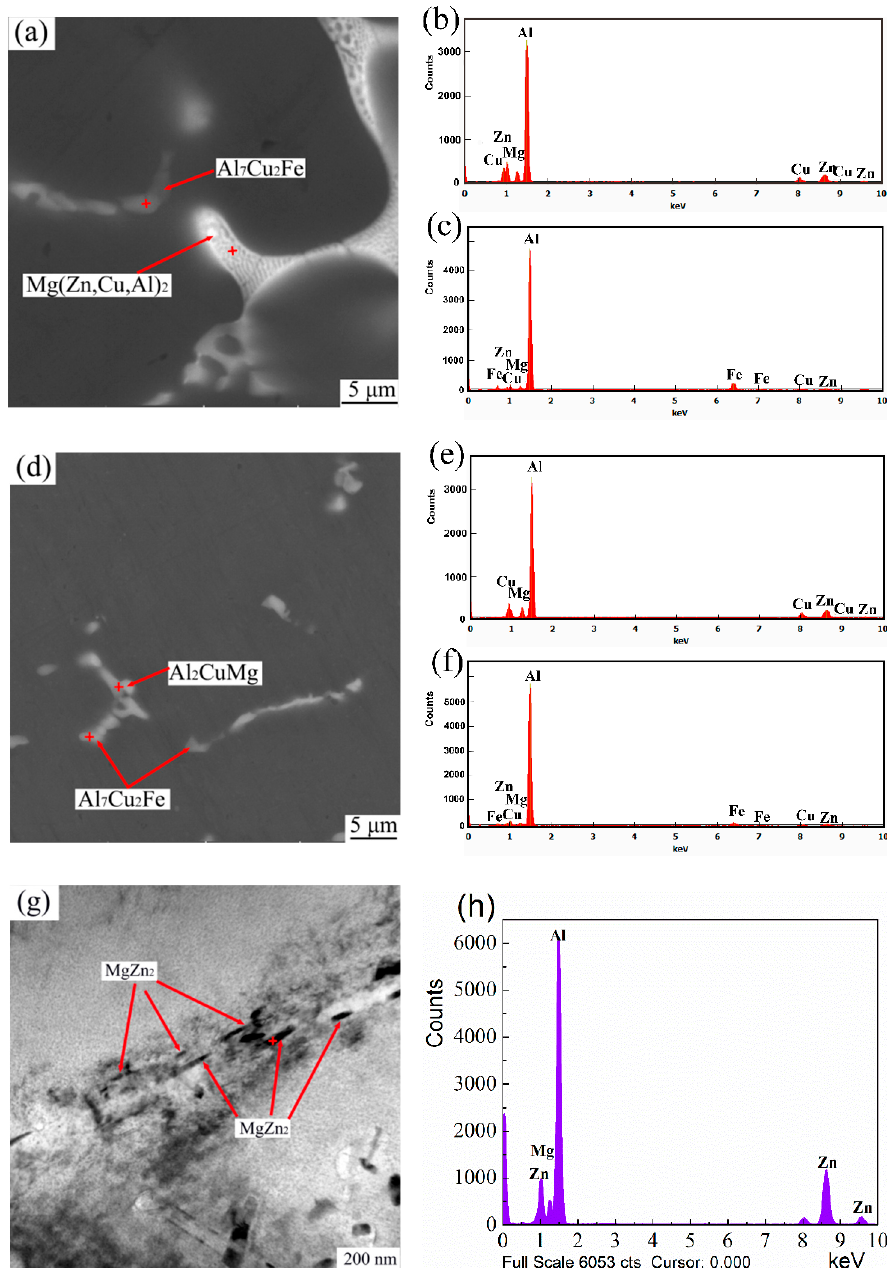
Figure 2. ( a ) The microstructure of eutectic phases of Al 2 O 3np /7075 composites; ( b ) The EDS spectra results of the Mg(Zn,Cu,Al) 2 phases; ( c ) The EDS spectra results of Al 7 Cu 2 Fe phases; ( d ) The microstructure of eutectic phases of Al 2 O 3np /7075 composites under solution treatment at 480 °C for 5 h; ( e ) The EDS spectra results of Al 2 CuMg phases; ( f ) The EDS spectra results of Al 7 Cu 2 Fe phases; ( g ) The TEM of precipitated phases of Al 2 O 3np /7075 composites under T6 heat treatment at 480 °C for 5 h and 120 °C for 24 h; ( h ) The EDS spectra results of MgZn 2 phases.